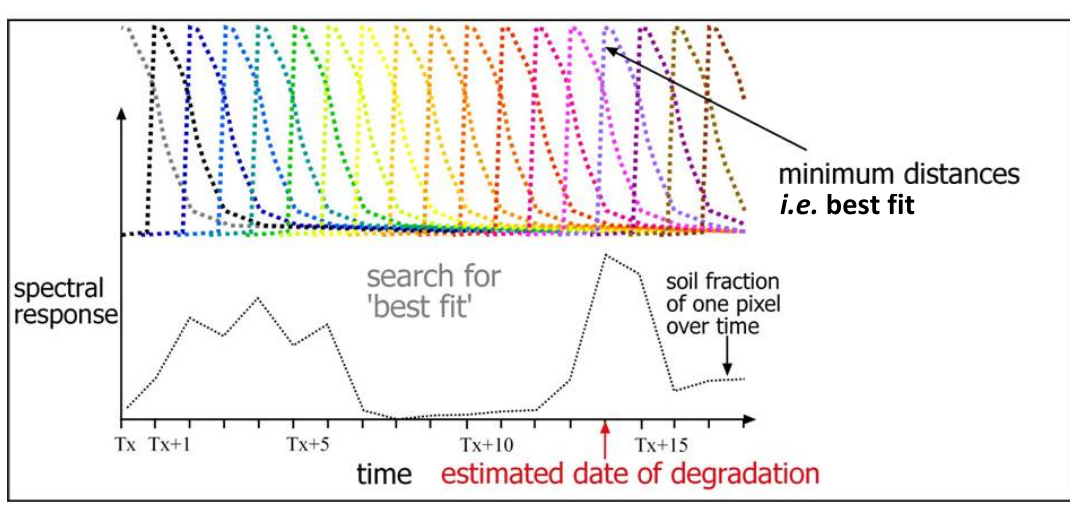
Figure 4. Schematically classification system for the multi-temporal stack of features (e.g., soil fraction). The soil fraction behavior of one example pixel (bottom: black line) is compared to typical behavior of degraded areas (top: colored lines) and classified to the best fitting